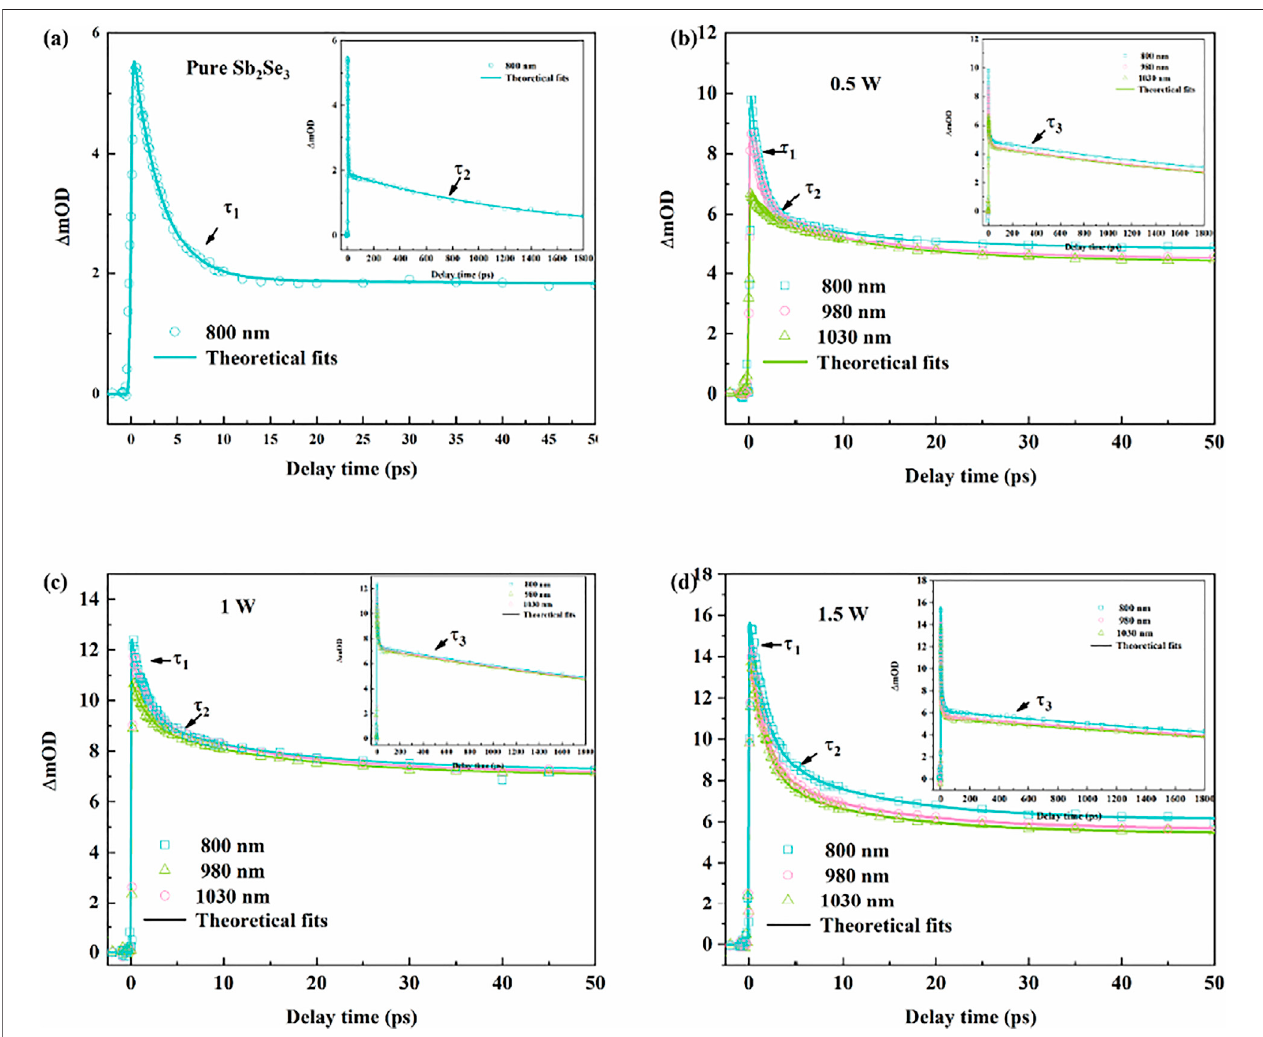
FIGURE 9 | (A) The transient nonlinear curve of pure Sb 2 Se 3 nano fi lm at different time scales. (B – D) The transient nonlinear curve of Co-doped Sb 2 Se 3 (0.5, 1.0, and 1.5 W) thin fi lms at different time scales.